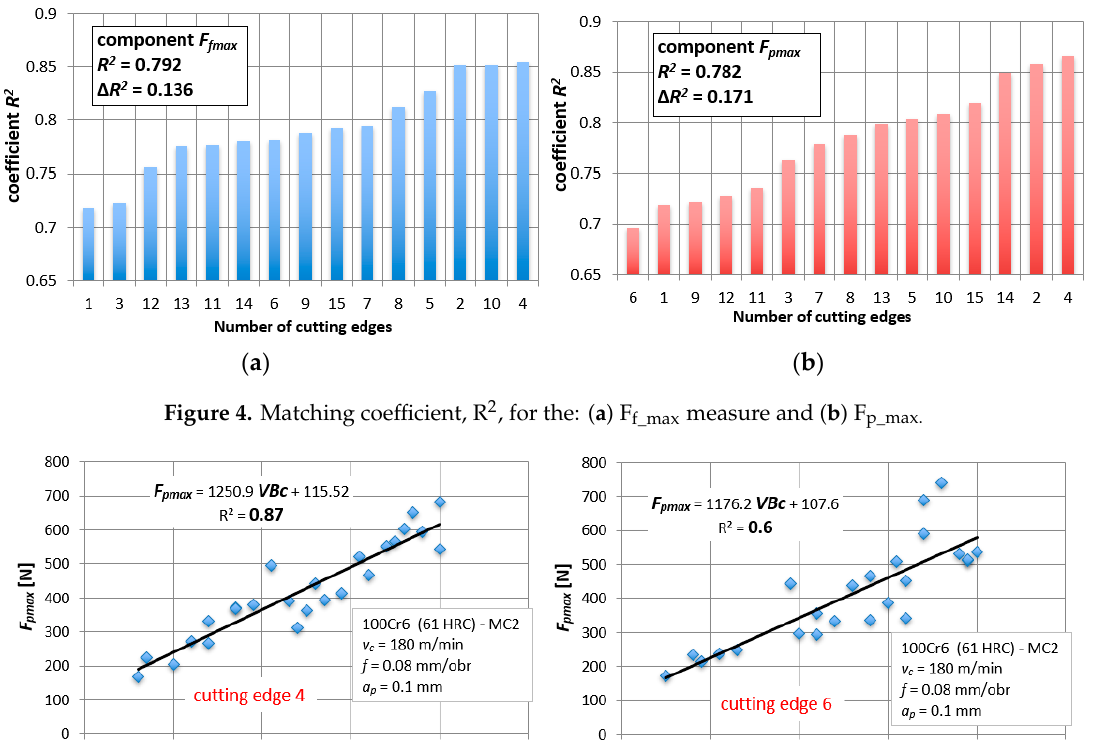
Figure 4. Matching coefficient, R 2 , for the: a) F f_max measure and b) F p_max.